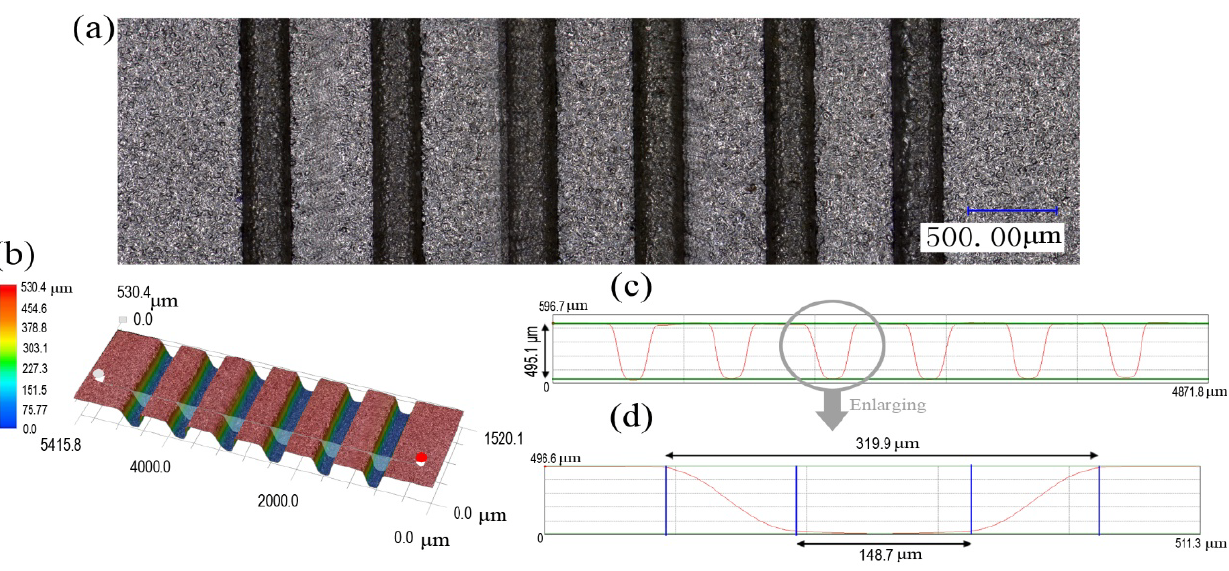
Figure 2. The shape of the rigid die: ( a ) the 2D plot of the rigid die; ( b ) the 3D plot of the rigid die; ( c ) the profile curve of the whole array micro-channels; ( d ) the profile curve of one micro-channel with detailed dimensions.